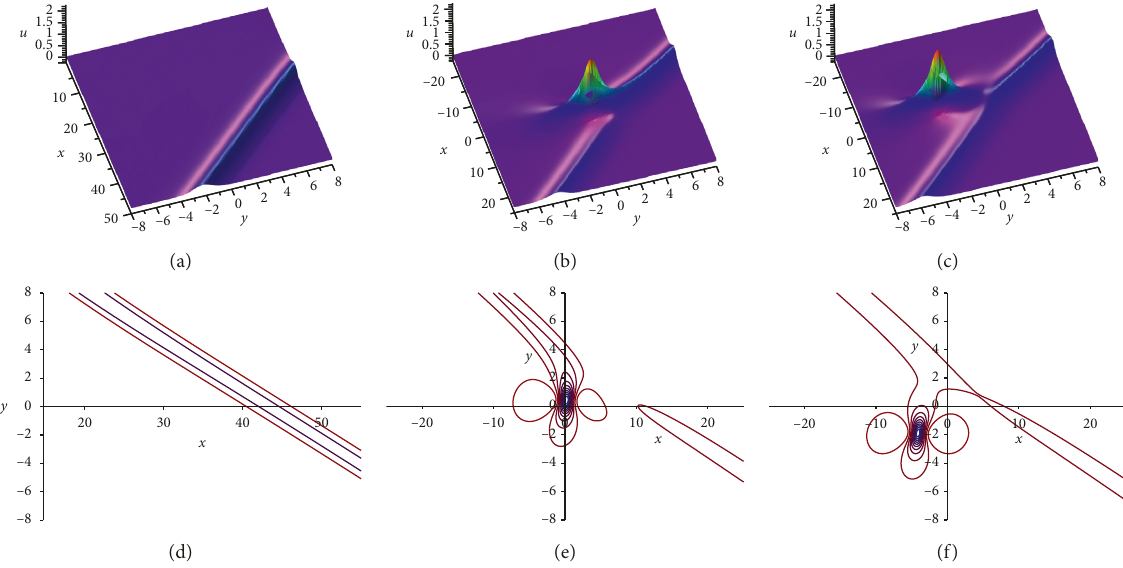
Figure 4: The propagations of the interaction solution between a lump wave and bright soliton (2) with (11) and (13) taking the parameters � 1/5, k � 3/4, a � 1/2, a � − ( 3/2 ) , a � 1/4, and a � − ( 3/2 ) at different times (a) t � − 40, (b) t � 0, and (c) t � 5. The contour plots m 0 1 2 3 4 8 at different times (d) t � − 40, (e) t � 0, and (f) t � 5.